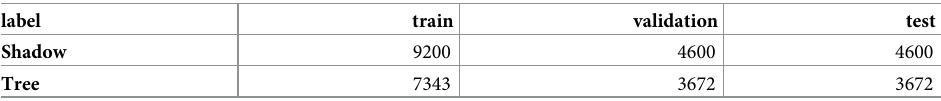
Table 3. Splits of train, test, and validation samples for Forest